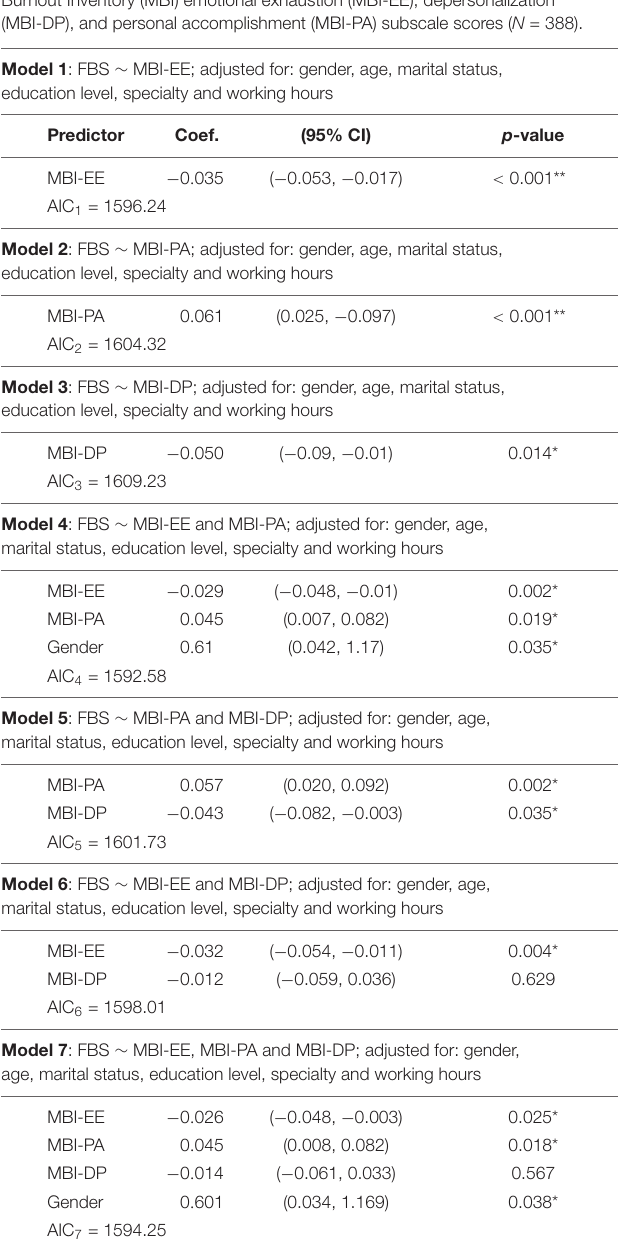
TABLE 5 | Spearman’s rank correlation coefficients between Maslach Burnout Inventory, Fuster-BEWAT score (FBS), and sleep scores (light sleep average, REM sleep average, and long interruptions) ( N = 47, * p <